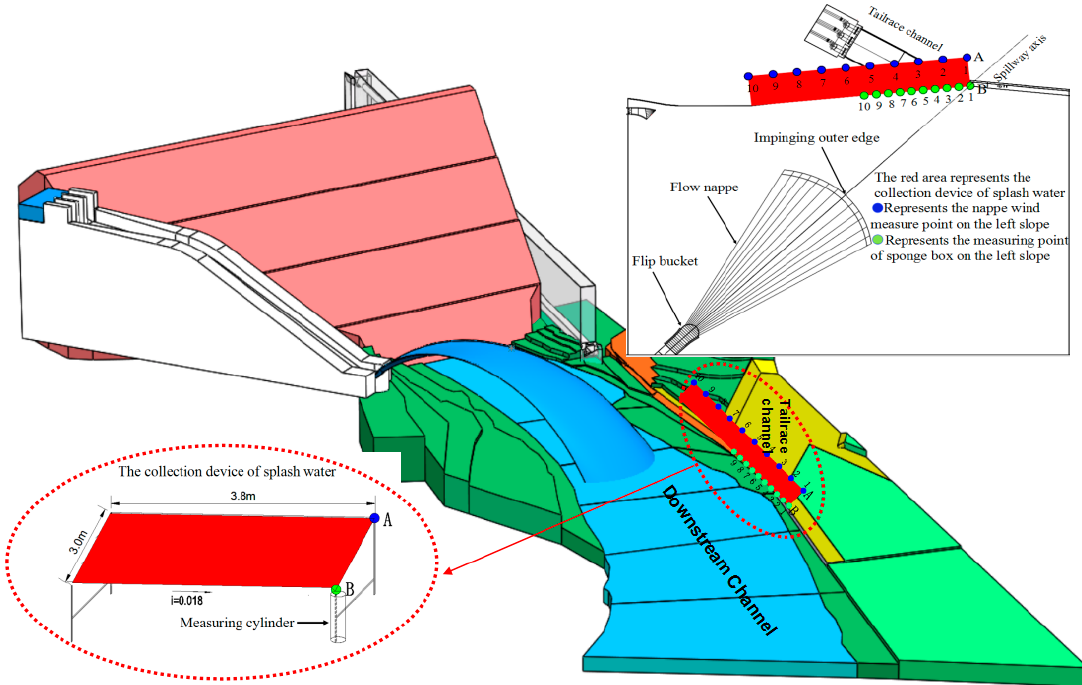
Figure 1. Arrangement of the physical model test.